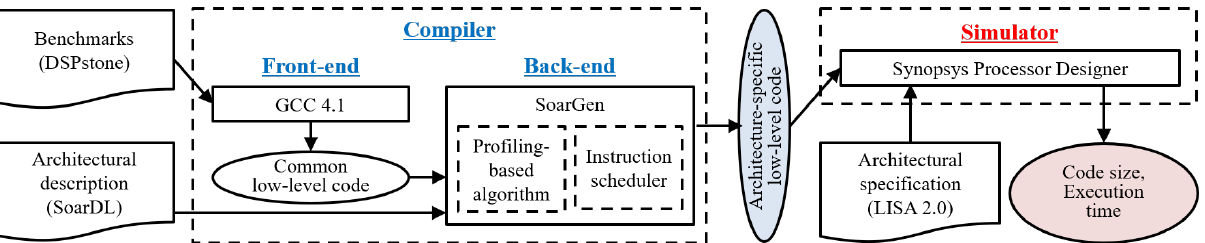
Figure 4. Our compiler-simulator framework to present the efficacy of our